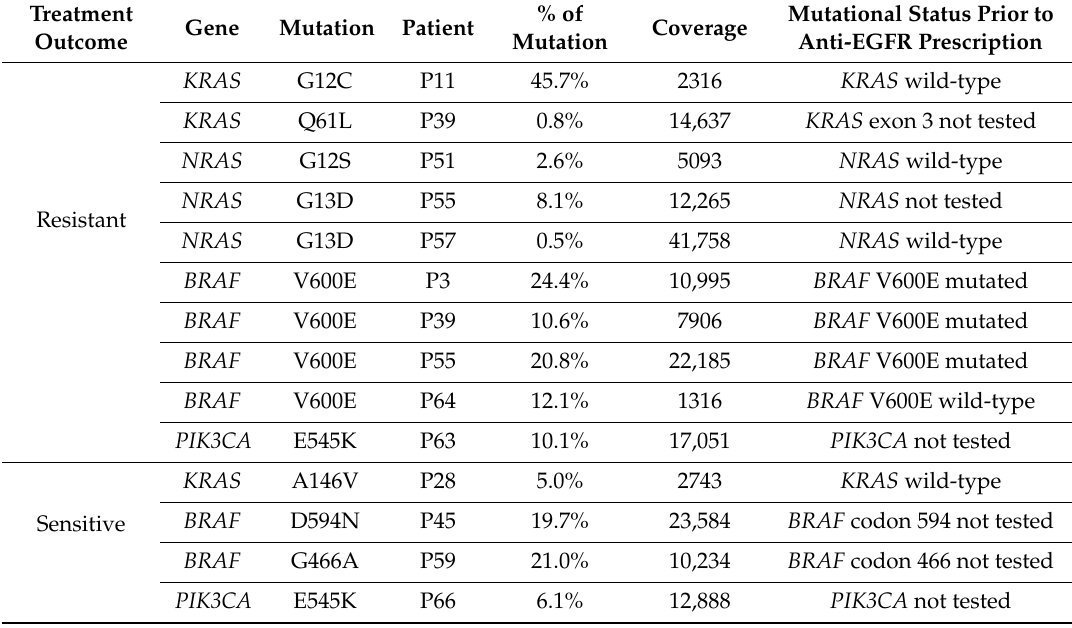
Table 3. Assessment of KRAS , NRAS, BRAF, and PIK3CA mutational status by next-generation sequencing.